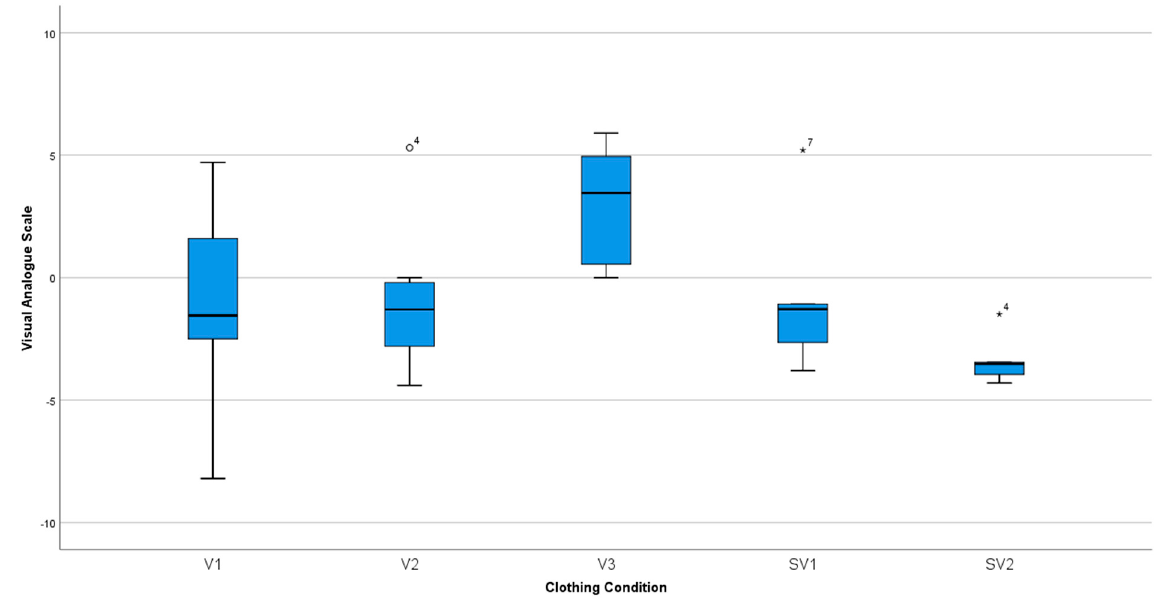
Figure 10. Subjective results of the crawl task compared to station wear.